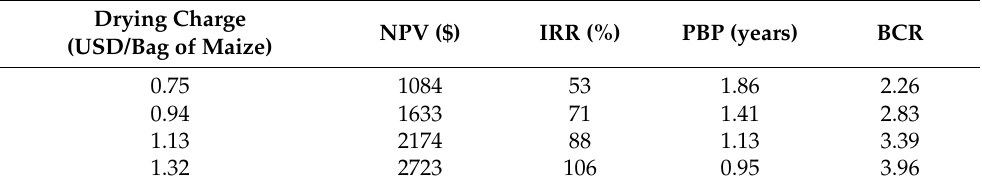
Table 5. Variation of NPV, IRR, PBP, and BCR with drying price charged per bag (130 kg) of maize. Drying Charge